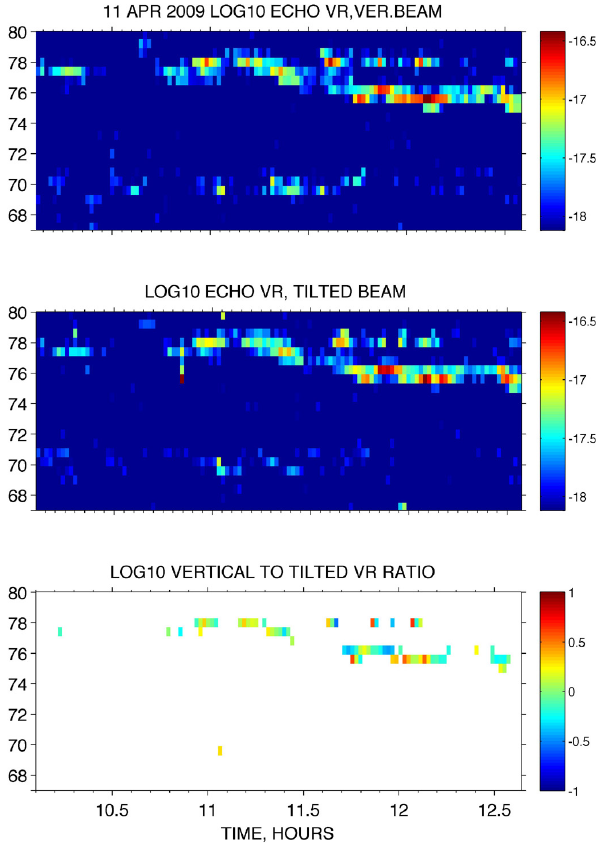
Fig. 6. Doppler vertical (upper panel) and meridional (middle panel) velocity and half spectral width for the vertical beam (lower panel) for the experiment on 11 April